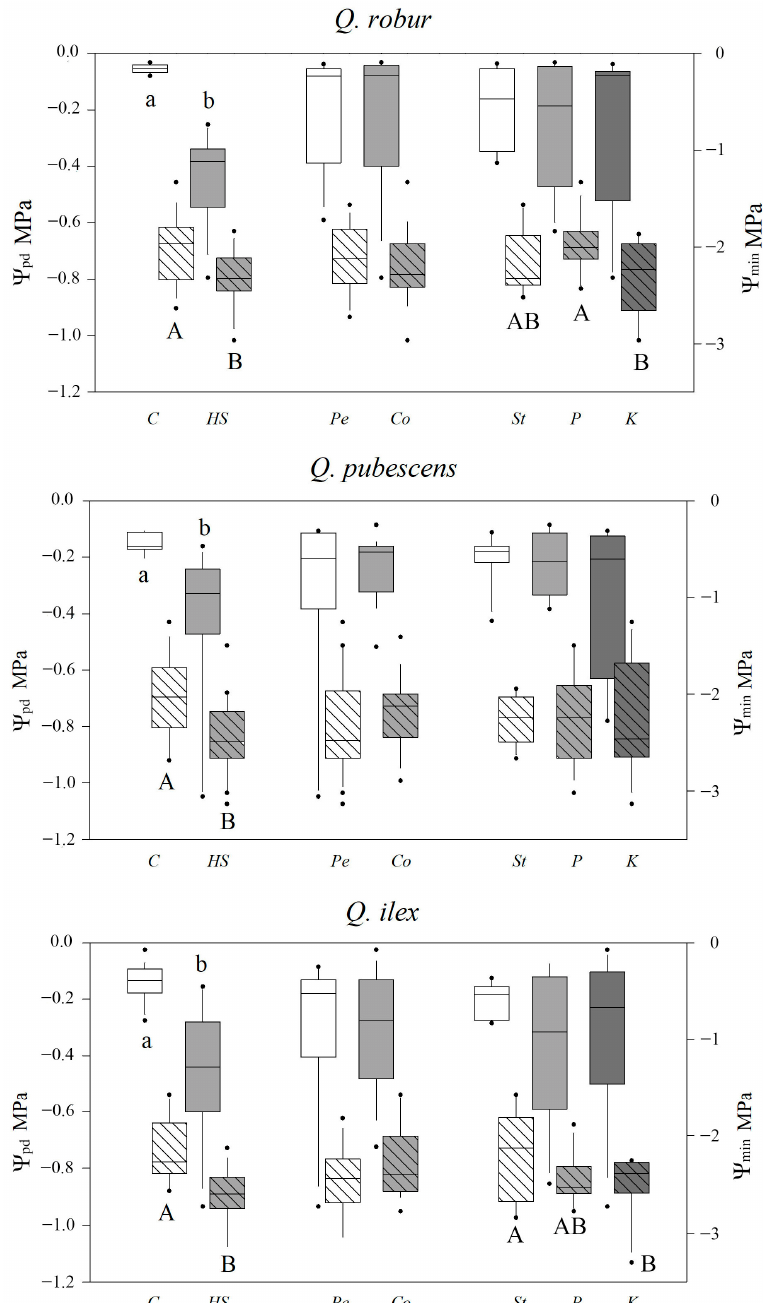
Figure 2. Boxplots of predawn ( Ψ pd , blank boxplot) and midday leaf water potential ( Ψ min , stripped boxplot) at T 1 . Lowercase and capital letters indicate homogeneous groups ( p ≤ 0.05) for Ψ pd and Ψ min , respectively. Levels as affected by studied factors: C , HS : control and high water stress; Pe , Co